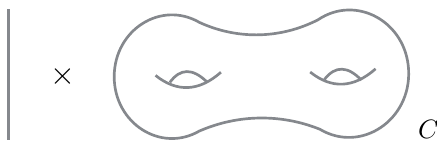
Figure 1 . We consider 3d = 2 supersymmetric gauge theories on the product of a line and a N Riemann surface C